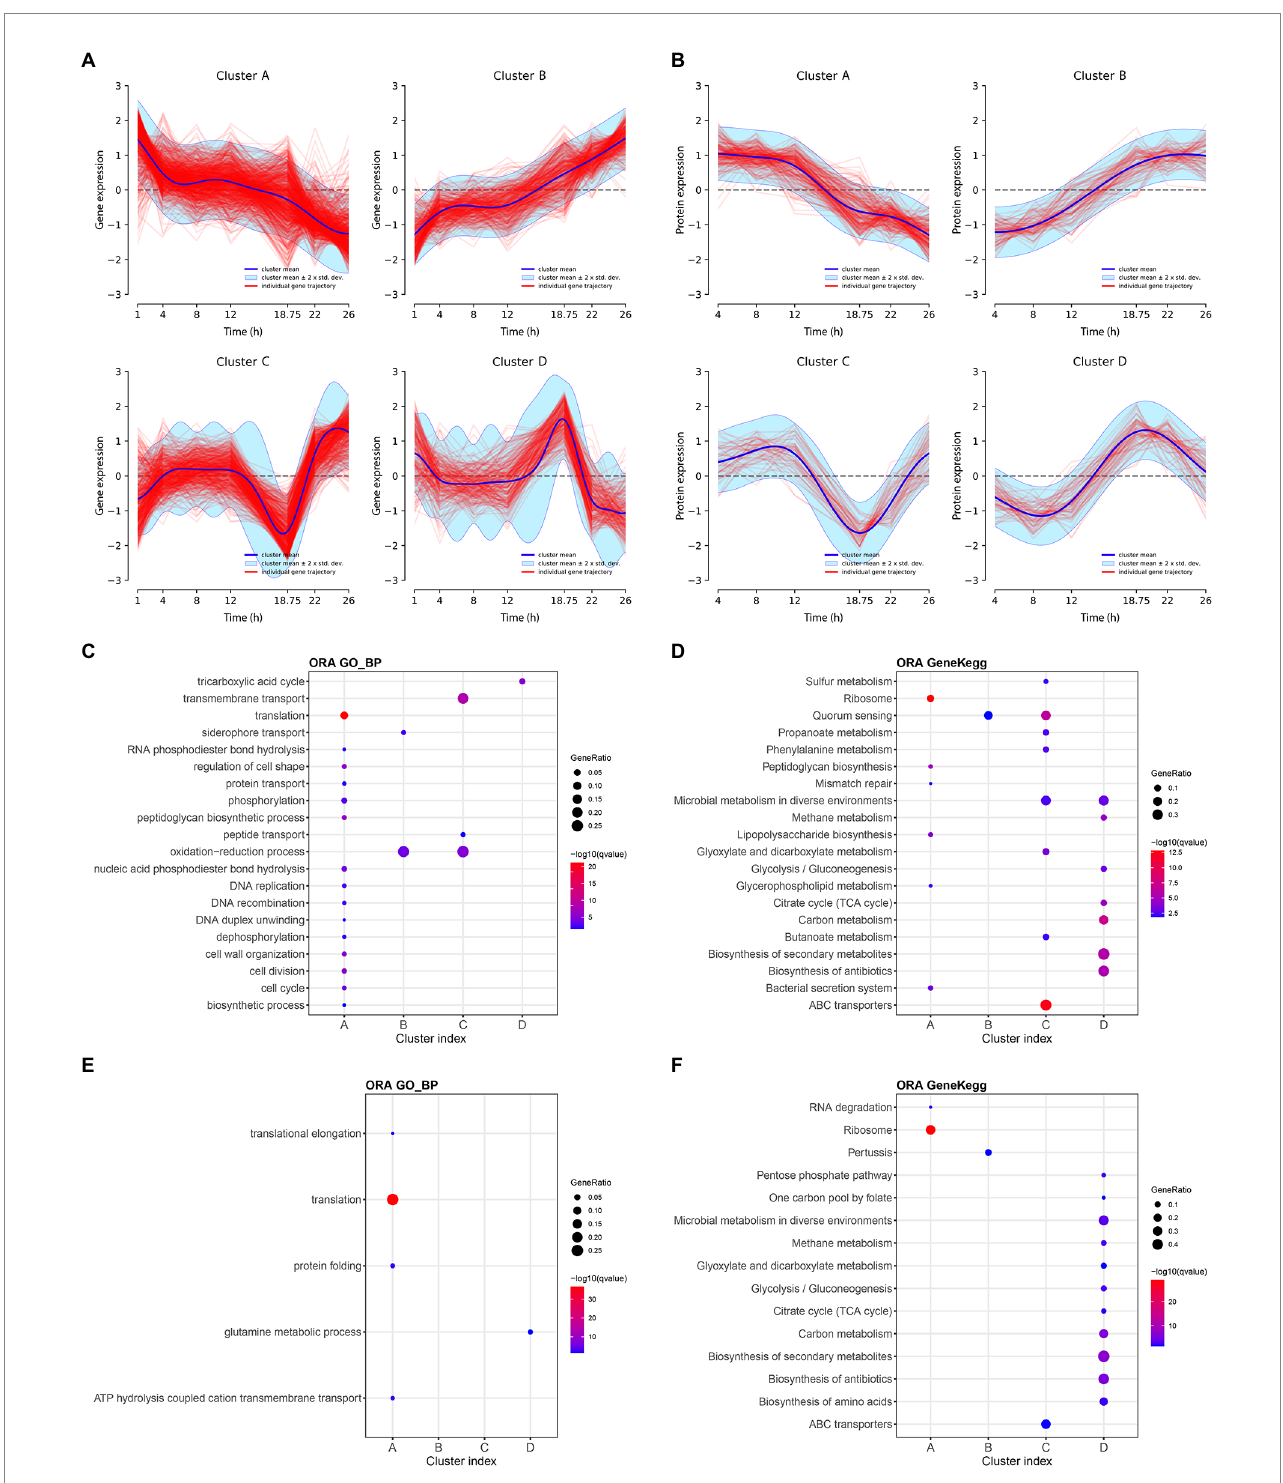
FIGURE 4 Main longitudinal clusters trajectories and pathway enrichment results of transcriptomic and proteomic data of Bordetella pertussis culture. Main longitudinal clusters trajectories of transcriptomic (A) and proteomic (B) data. X -axis correspond to the time and Y -axis correspond to the gene expression or the protein intensity. Blue line corresponds to the cluster mean, light blue interval corresponds to the cluster mean ± 2 × SD and red line corresponds to the individual transcript or protein trajectories. Over representation analysis (ORA) pathways enrichment on Gene Ontology and KEGG databases for transcriptomic ( C,D , respectively) and proteomic ( E,F , respectively). Enriched pathways are shown in Y -axis and associated cluster in X -axis. Colors of spots (blue to red) are according to the significance of pathways enrichment in each cluster. Size of spots are according to the Gene ratio (= number of transcripts or proteins in a cluster which mapped on a pathway/Number of transcripts or protein in this cluster which mapped in the database). Maximum number of pathways = 20. Maximum q -value =